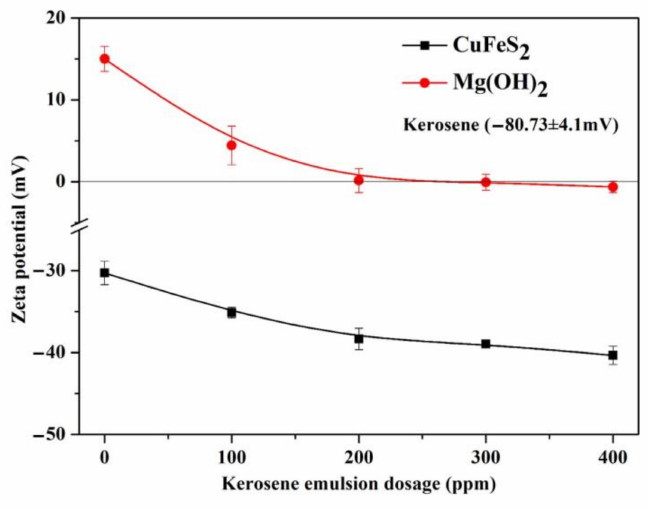
Figure 7. Zeta potentials of chalcopyrite particles and Mg(OH) 2 precipitates as a function of kerosene dosage in pure water, controlled at pH